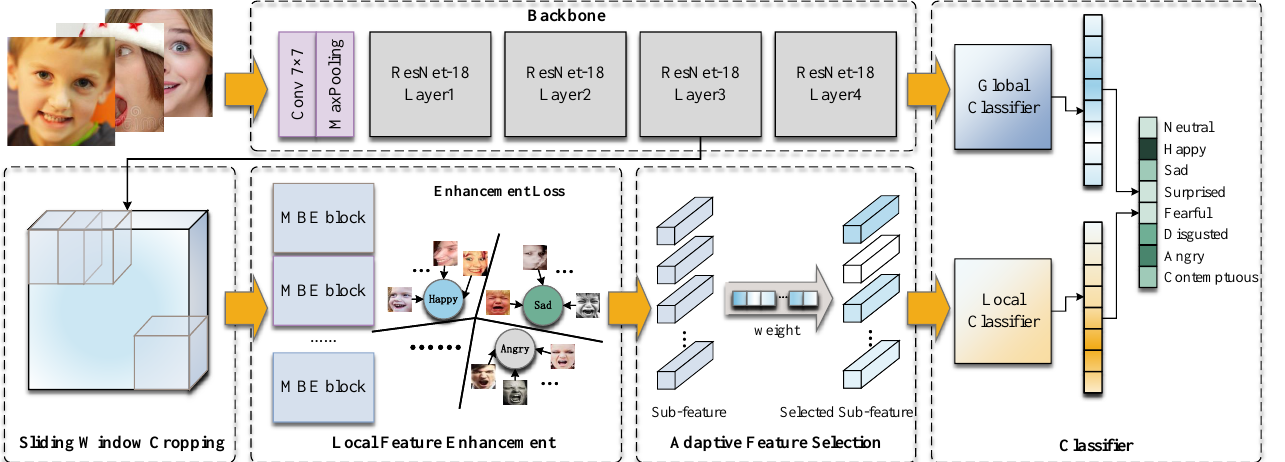
Figure 2. Overview of the SWA-Net model. ResNet-18 serves as the backbone to mine global features. Local features are obtained through the Sliding Window Cropping module, Local Feature Enhancement module, and Adaptive Feature Selection module. Finally, the global classifier and local classifier are used independently to jointly predict the